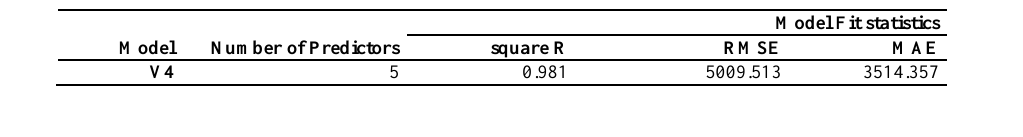
Table 12. The obtained error value using the time series method of ARIMA model by studying the factors in previous studies.